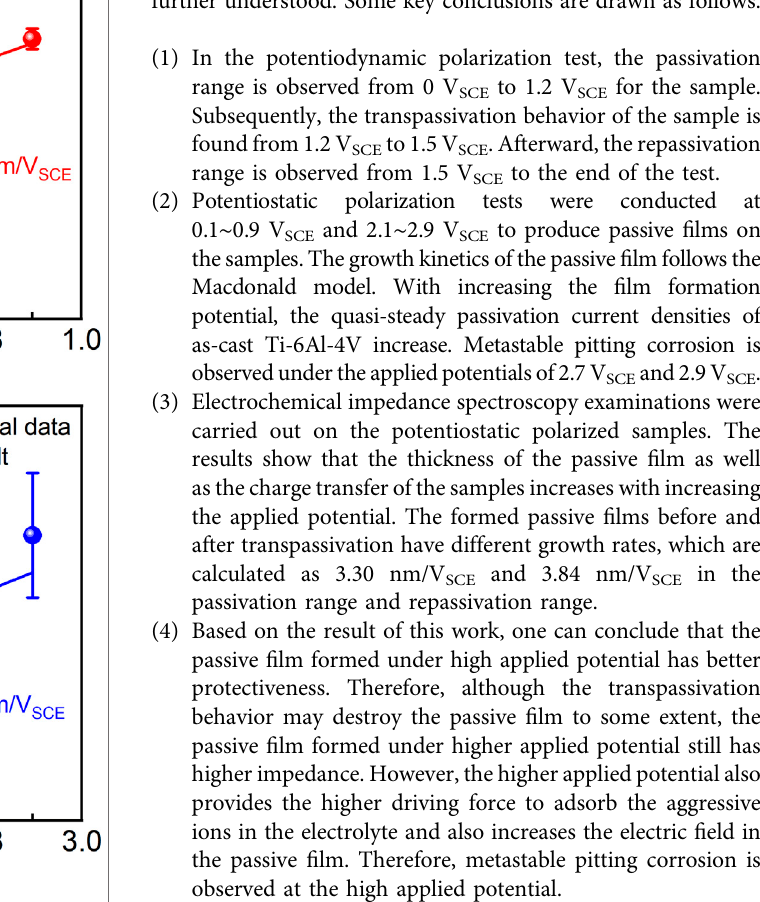
Frontiers in Materials |